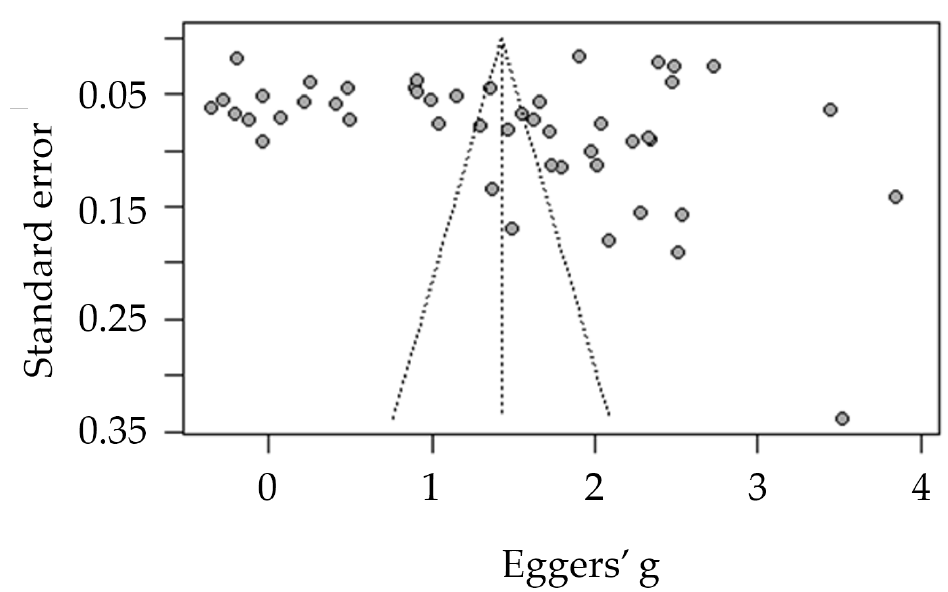
Figure 2. Funnel plot of publication bias of the included studies.